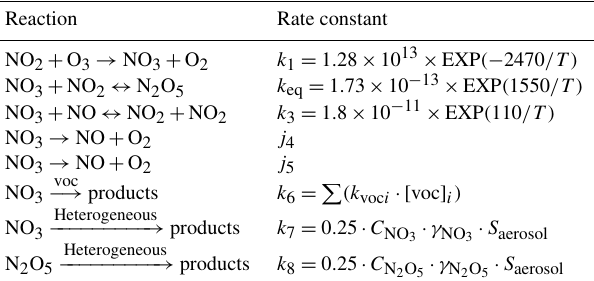
Table 1. Major gas-phase and heterogeneous reactions involving NO 3 and N 2 O 5